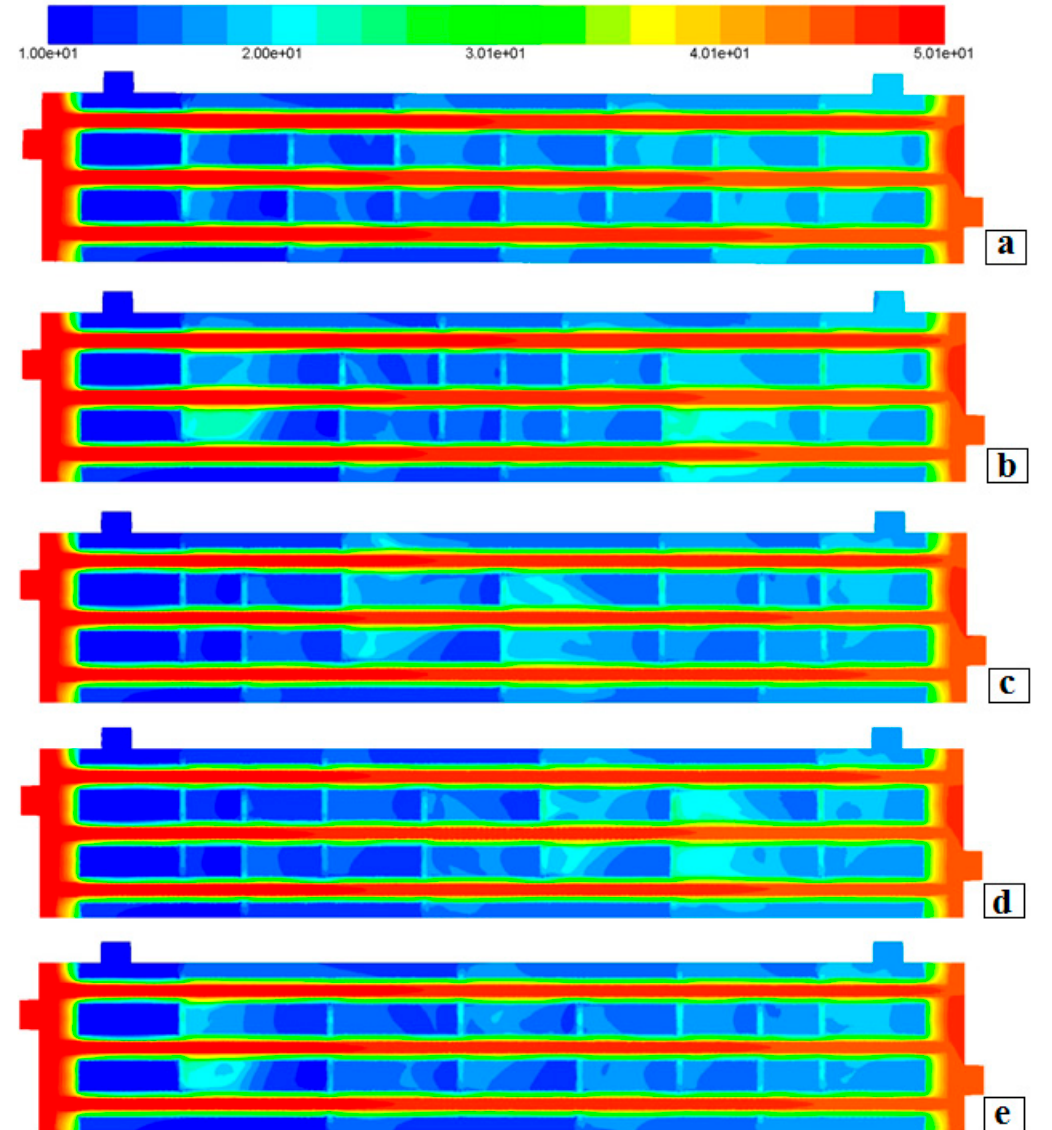
Figure 15. Temperature distribution at the center plane of the heat exchanger ( a ) Case-I ( b ) Case-II ( c ) Case-III ( d ) Case-IV ( e ) Case-V. Table 8. CFD results of velocity distribution for each fluid zone (m/s).